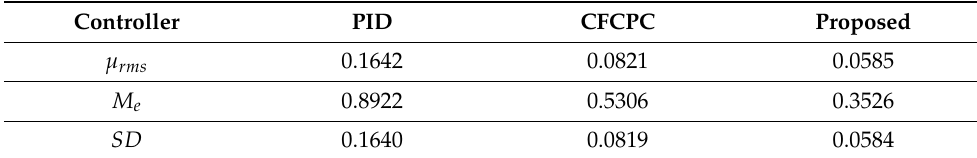
Table 3. Performance indexes of three controllers in